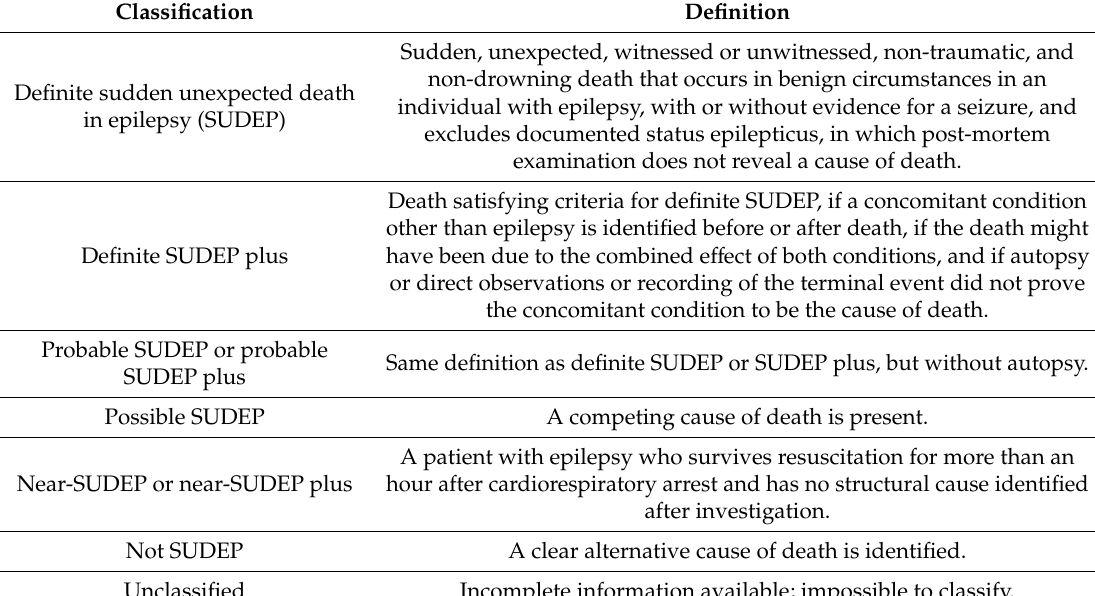
Table 1. Proposed sudden unexpected death in epilepsy (SUDEP) definition and classification